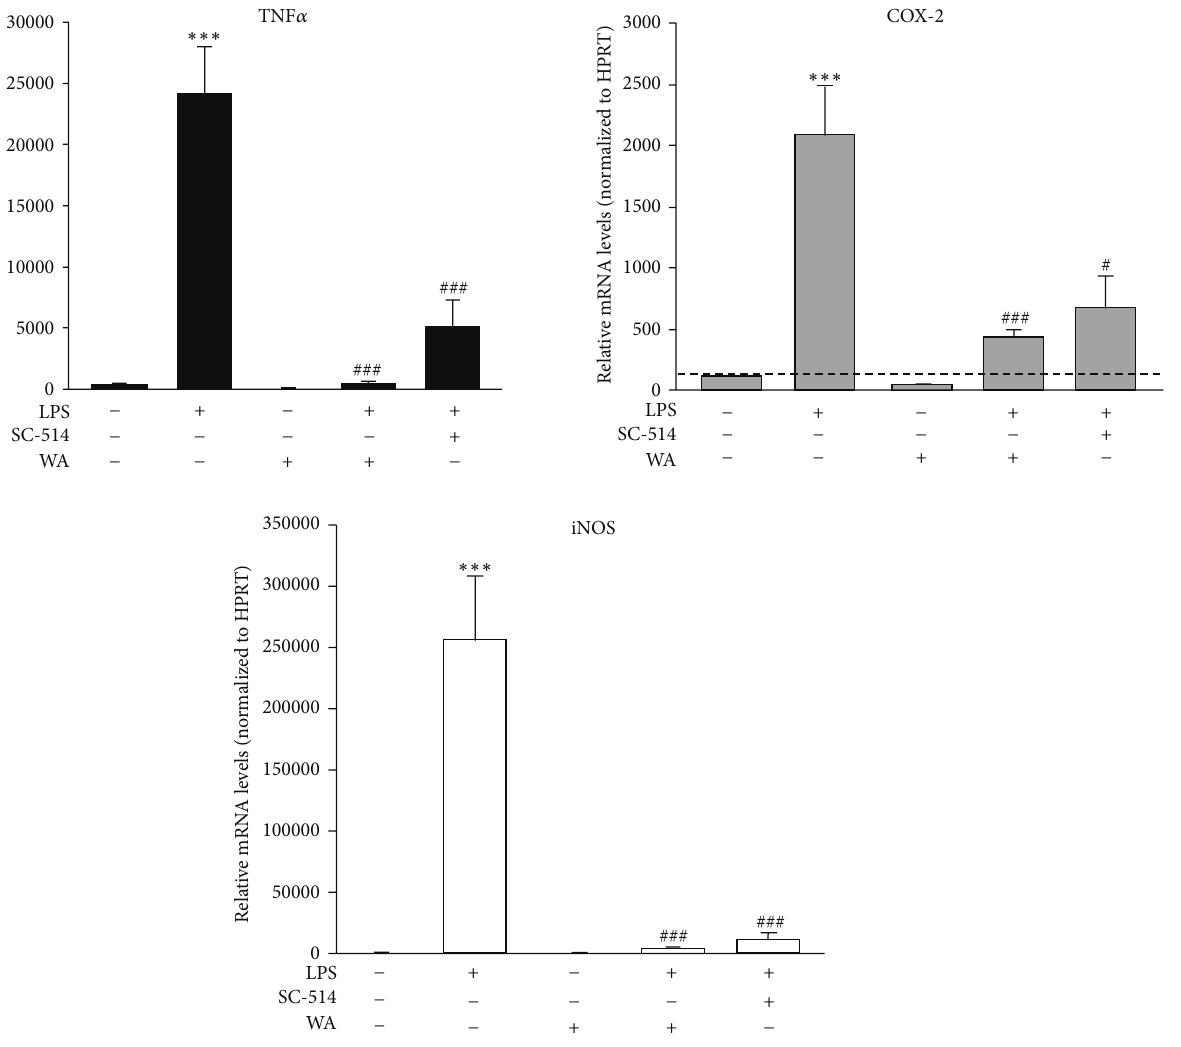
Figure 4: Pre-treatment with Withaferin A reduces the expression of TNF 𝛼 , COX-2, and iNOS triggered by LPS in primary spinal cord astrocytes. Primary astrocytes were pre-treated with 10 𝜇 M SC-514, a selective NF- 𝜅 B inhibitor, or 0.5 𝜇 M Withaferin A (WA) for 1 hour and then incubated in the presence or in the absence of LPS (1 𝜇 g/mL) for 6 hours. Total RNA was extracted and reverse-transcribed. TNF 𝛼 , COX-2, and iNOS mRNA levels were analyzed by RT-qPCR ( 𝑛 = 3 experiments in triplicate). Values (mean ± s.e.m.) were normalized relative to HPRT and expressed as percentage of TNF 𝛼 , COX-2, or iNOS expression levels in control conditions ( ∗∗∗ 𝑝 < 0.0001 versus control, ### 𝑝 < 0.0001 and # 𝑝 < 0.01 versus LPS; one-way ANOVA followed by Bonferroni post hoc